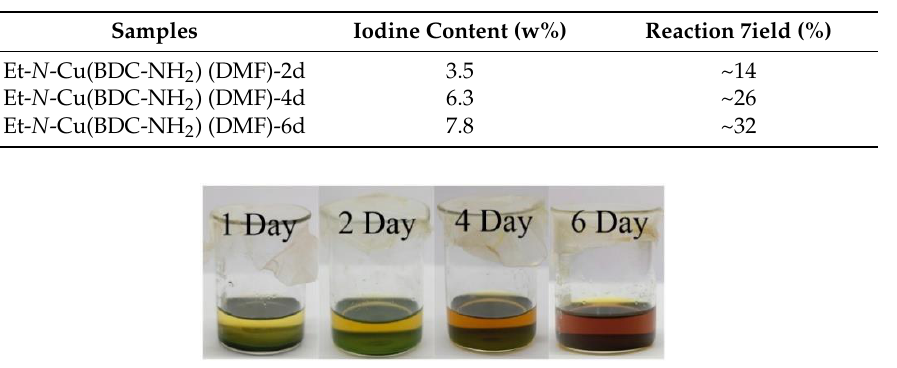
Figure 11. Quaternization reaction from Cu(BDC-NH 2 )(DMF) to Et- N -Cu (BDC-NH 2 ) (DMF). Activated carbon and Cu(NO 3 ) 2 ·3H 2 O were purchased from Alfa Aesar (Beijing, China). Pd(CN) 4 2− , Co(CN) 6 3− , Fe(CN) 63 − , and 2-aminoterephthalic acid were purchased from Sigma-Aldrich